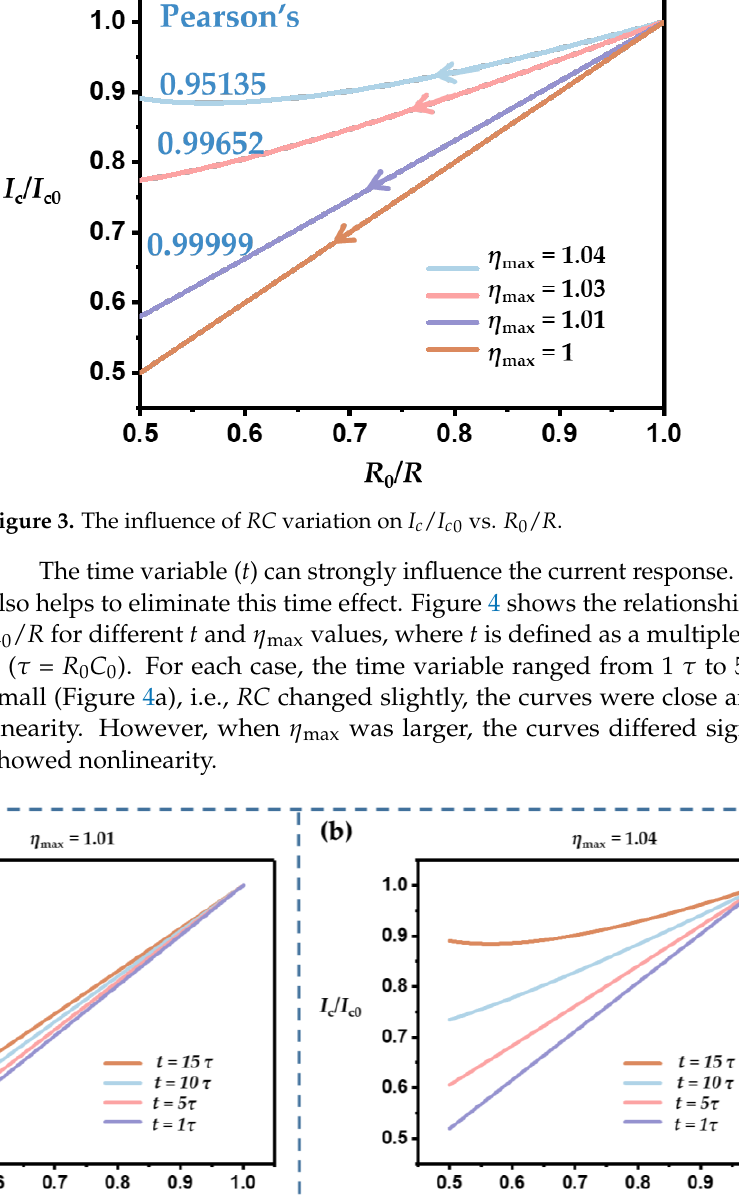
Table 1. Key parameters used in the simulation. Parameter